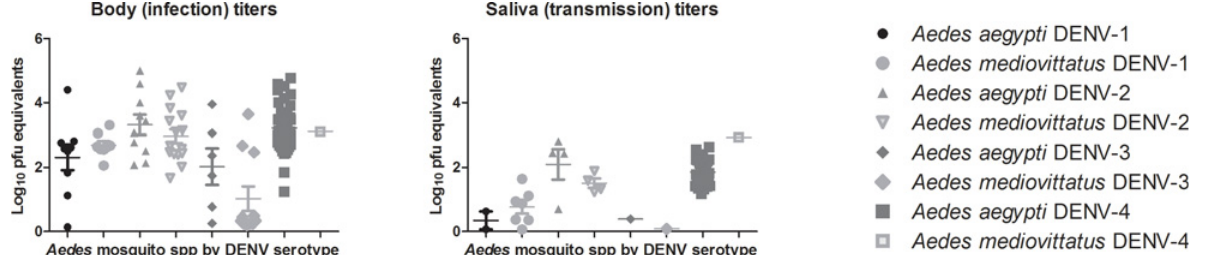
Figure 1. Body (infection) and saliva (transmission) titers of dengue virus-infected Aedes mediovittatus and Aedes aegypti mosquitoes 14 days after oral challenge with dengue-1 (DENV-1) (HAW), DENV-2 (New Guinea C), DENV-3 (H87), DENV-4 (H241). Non-zero mean titer, 25 percentile titer, and 75 percentile titers are indicated on the